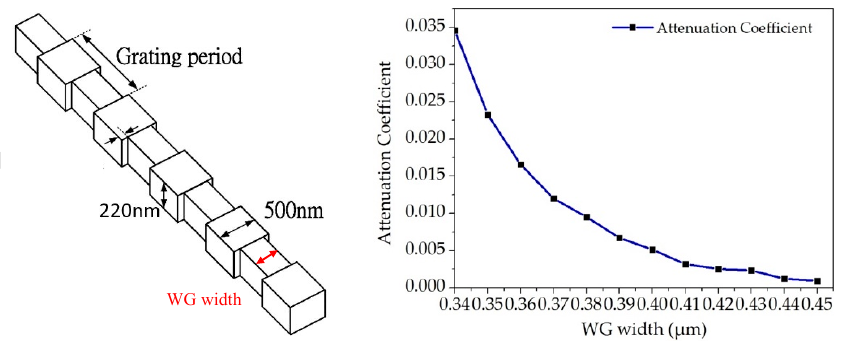
Figure 4. The FDTD was used to simulate a 12 period FBG on various narrow grating waveguide widths under a 500 nm wider width for the attenuation coefficient.